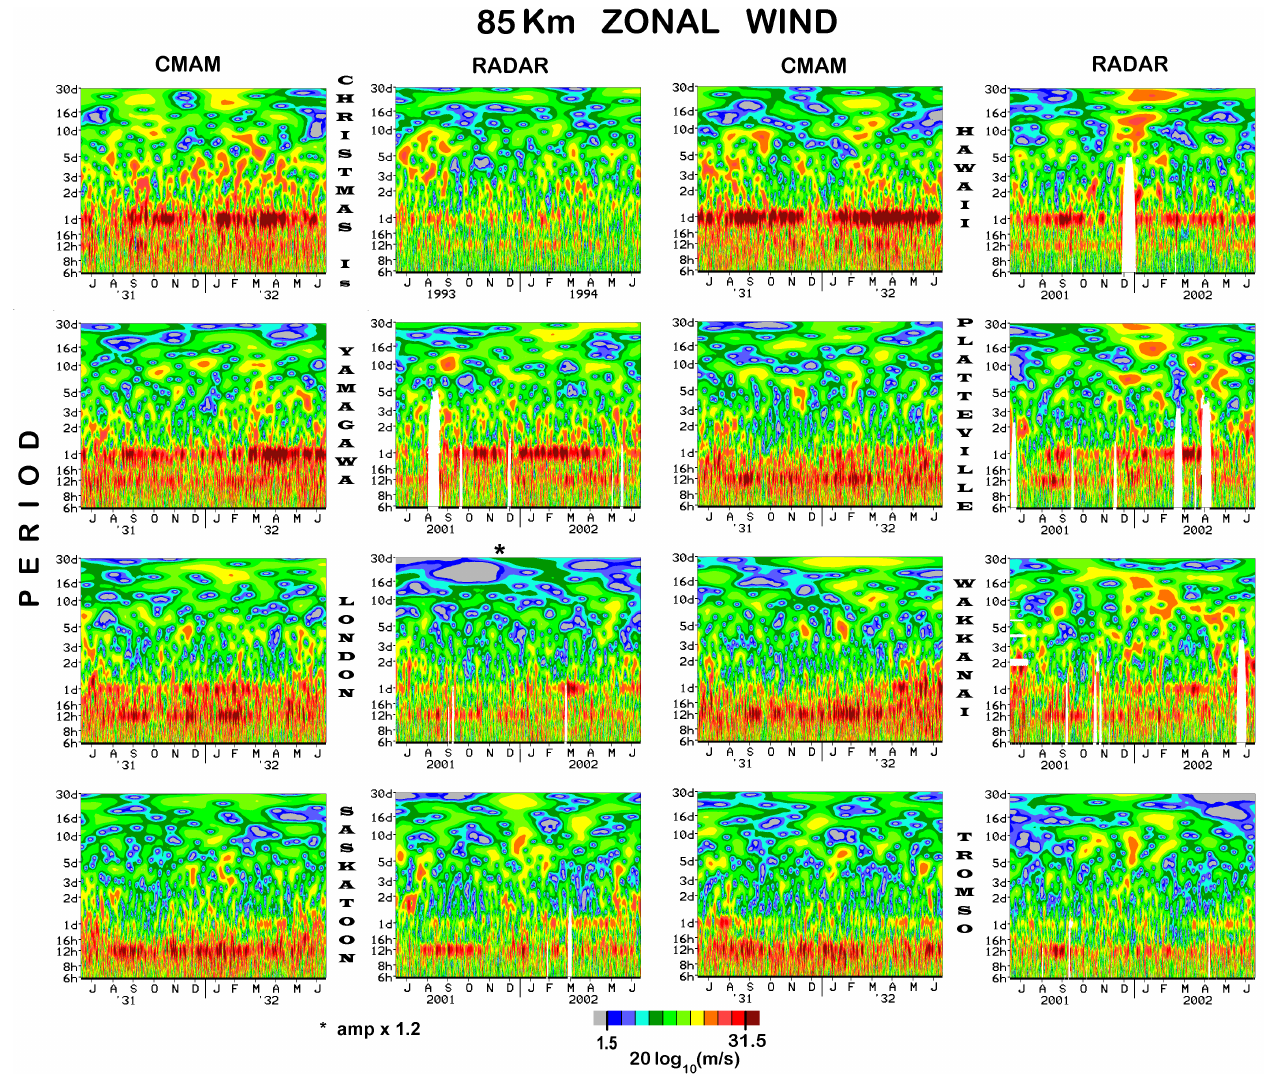
Fig. 2. Wavelet analysis of 85km zonal wind data from the MF radars and from the CMAM model: the locations are those of the MF radars, Christmas Island to Tromsø. The years are the same as for Fig. 1: 2001/02 and model-years 31/32. Data amplitudes from London’s MFR are multiplied by a factor of 1.2 due to a bias in the local